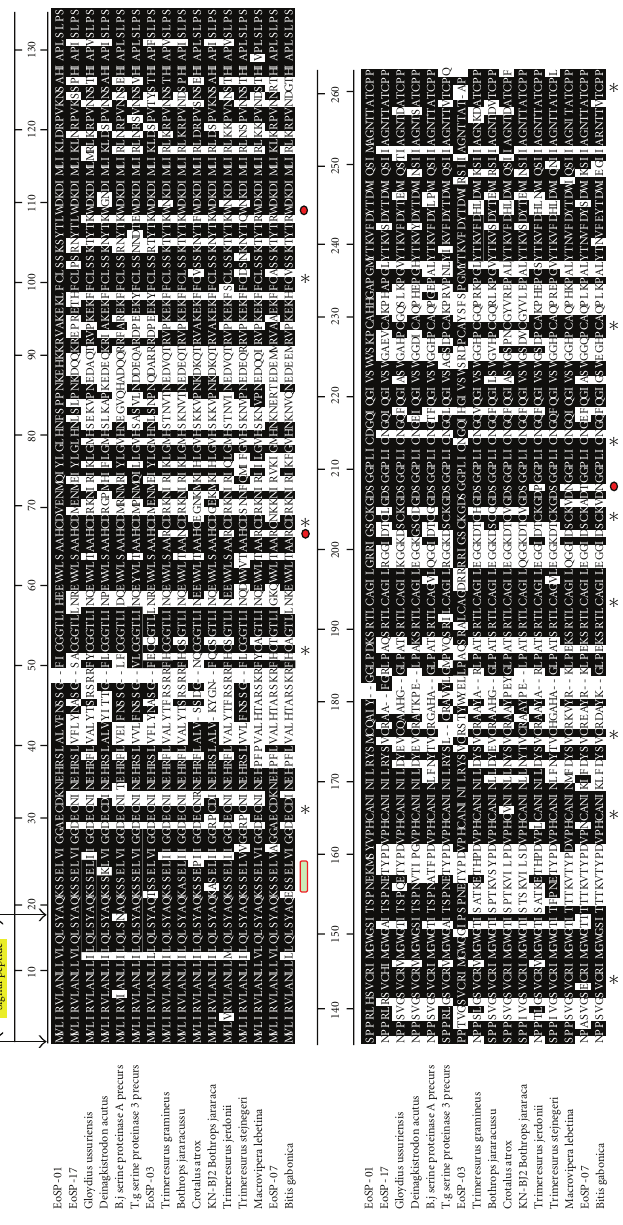
Figure 4: Amino acid sequence similarity between EoSP Variants and serine proteases from related vipers. The residues shaded in black correspond to residues that are identical to EoSP-01. The asteriks [ ∗ ] represented the tweleve conserved cysteine residues. The catalytic traid His / Arg (67), Asp (110) and Ser (208) are represented in red circules. Activated peptide where the mature proteine cleaved is represented by green